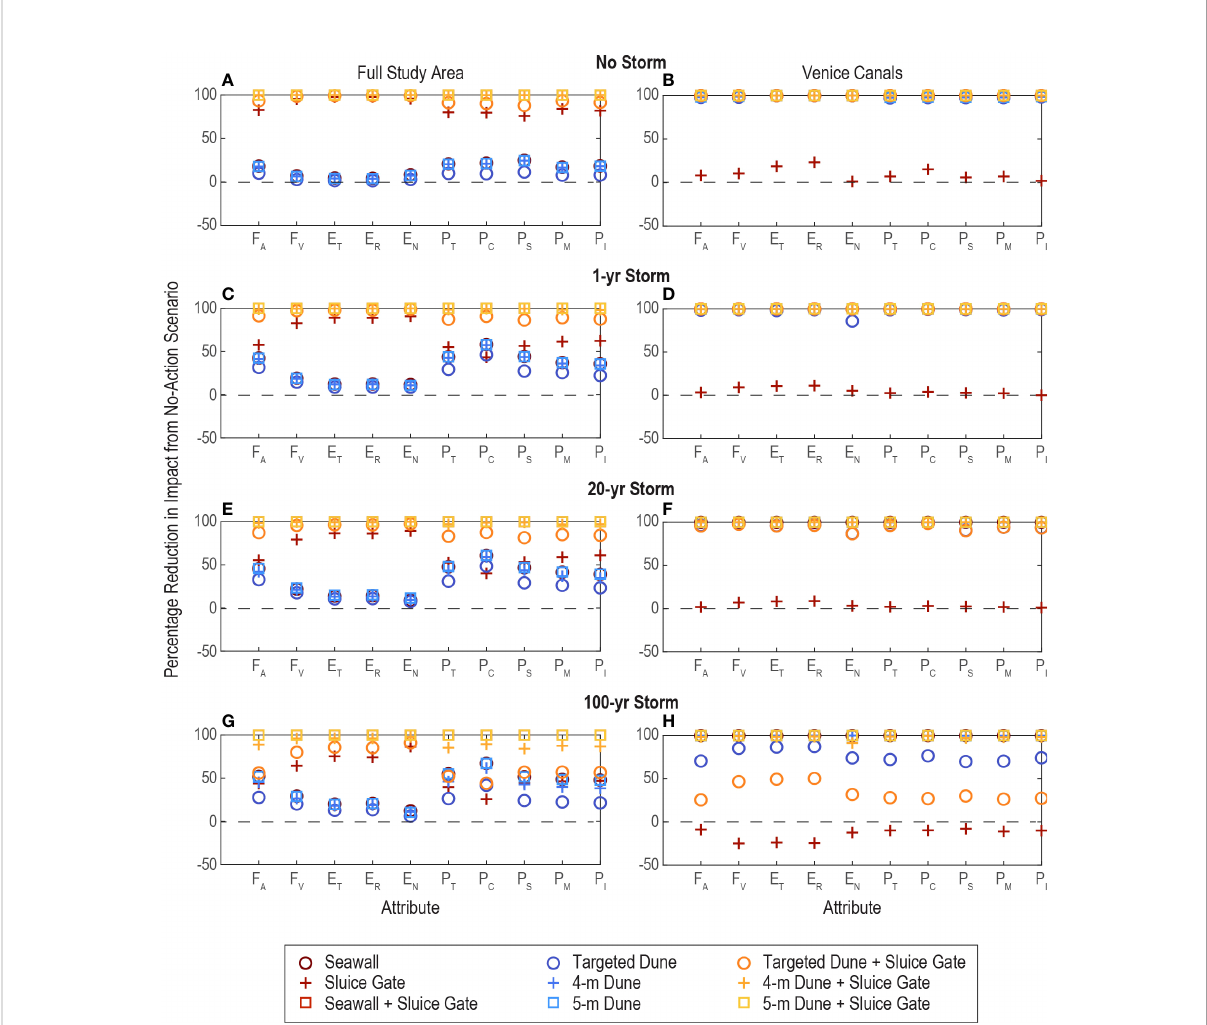
FIGURE 6 Percentage reduction in hydrodynamic, economic, and demographic impacts of strategies compared to the no-action scenario for (A, B) no storm, (C, D) a 1-year storm, (E, F) a 20-year storm, and (G, H) a 100-year storm. Results for the full study area are shown in the left column and the Venice Canals in the right column. Results above 0% indicate a reduction in fl ood impact from implementing the adaptation strategy, while results below 0% indicate an increase in fl ood impact. FA, fl ood area; FV, fl ood volume; ET, total economic damages; ER, residential economic damages; EN, nonresidential economic damages; PT, total population; PC, child population; PS, senior population; PM, minority population; PI, low-income